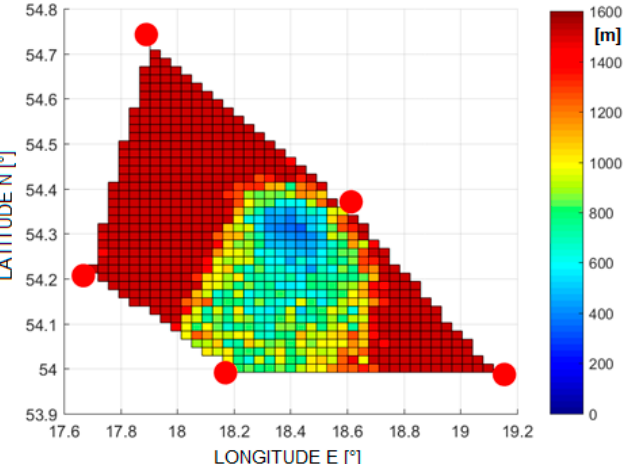
Figure 5. The RMSE of 2D position estimation in (m) for the SI algorithm (TDoA error is ±2 μ s).